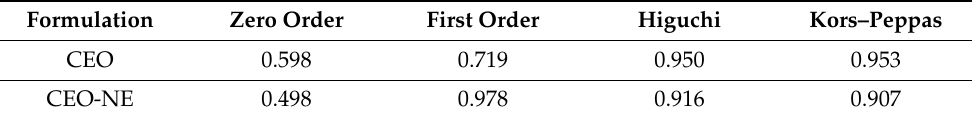
Figure 4. Comparative kinetic data for CEO (upper) and CEO-NE (lower): ( a ) zero order; ( b ) first order; ( c ) Higuchi; ( d ) Kors–Peppas. Table 1. Drug release kinetics of CEO and